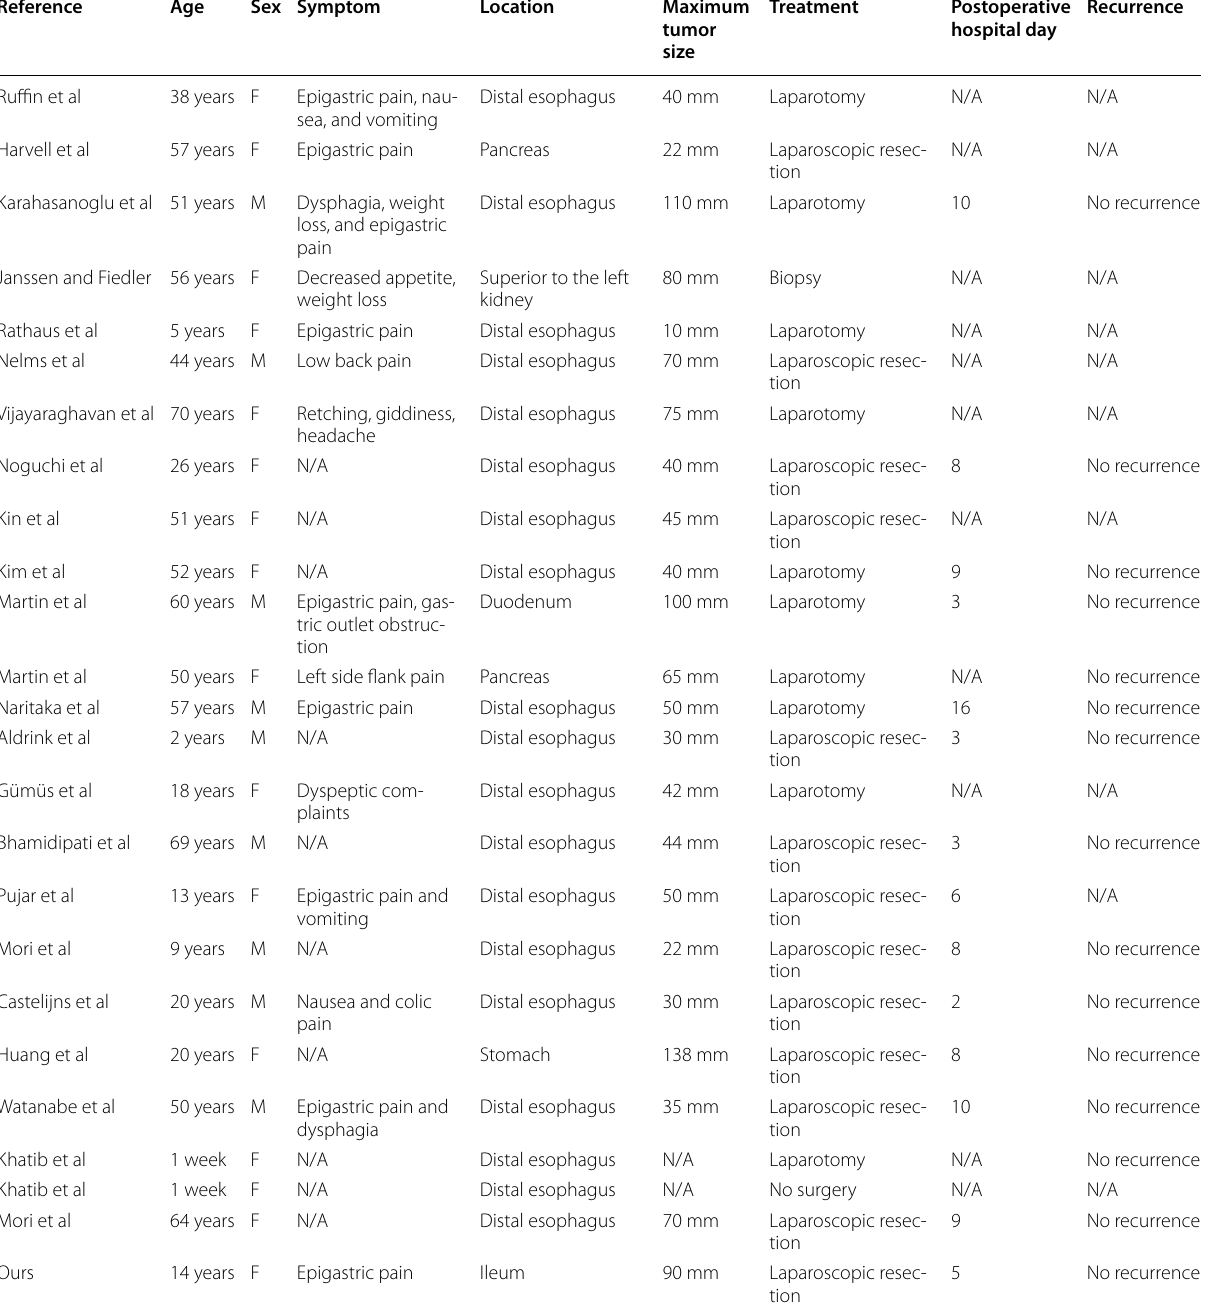
Table 1 Characteristics of 25 published cases of intra-abdominal esophageal duplication cyst (EDC), including our